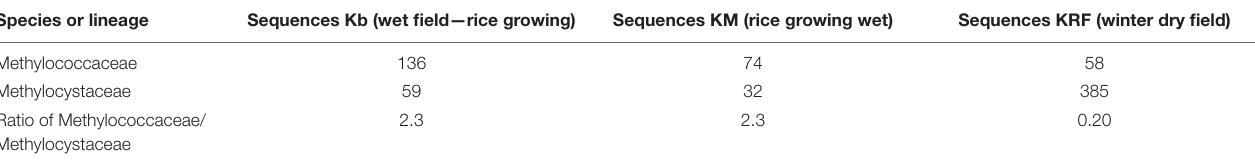
FIGURE 3 | Bar diagram representing the distribution of the sequences obtained from the 16S rRNA gene-based next-generation sequencing (NGS) analysis affiliated to their nearest cultivated members. TABLE 2 | Total number of sequences of methanotrophs from 16S rRNA gene-based next-generation sequencing (NGS) analysis data. Species or lineage Sequences Kb (wet field—rice growing) Sequences KM (rice growing